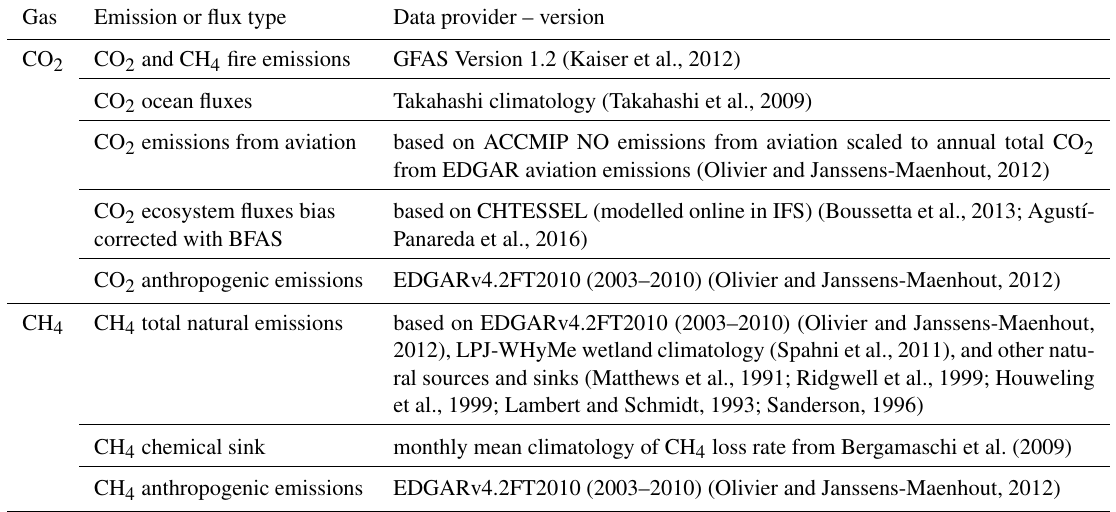
Table 2. Specifications of the emission and surface fluxes used in the CAMS GHG